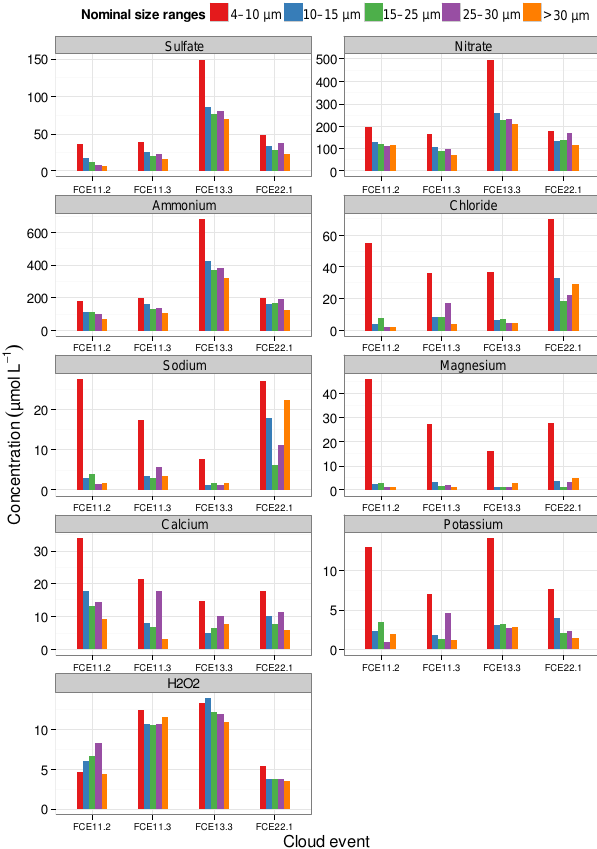
Figure 9. Size-resolved cloud water concentrations from three- stage collector. Volume-weighted mean concentrations per event are given in µmolL − 1 except for DOC (mgCL − 1 )